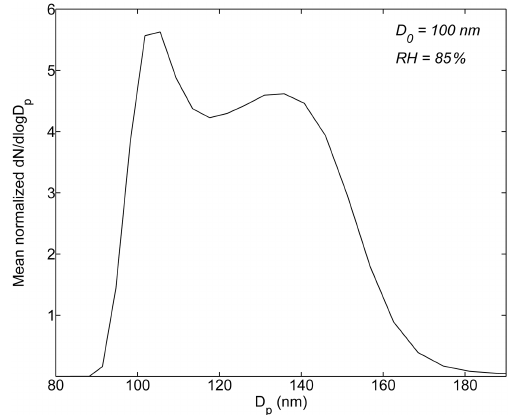
Figure 1. Normalized particle number size distribution ((d N/ dlog D p ) /N ) after humidification averaged over the en- tire haze observation